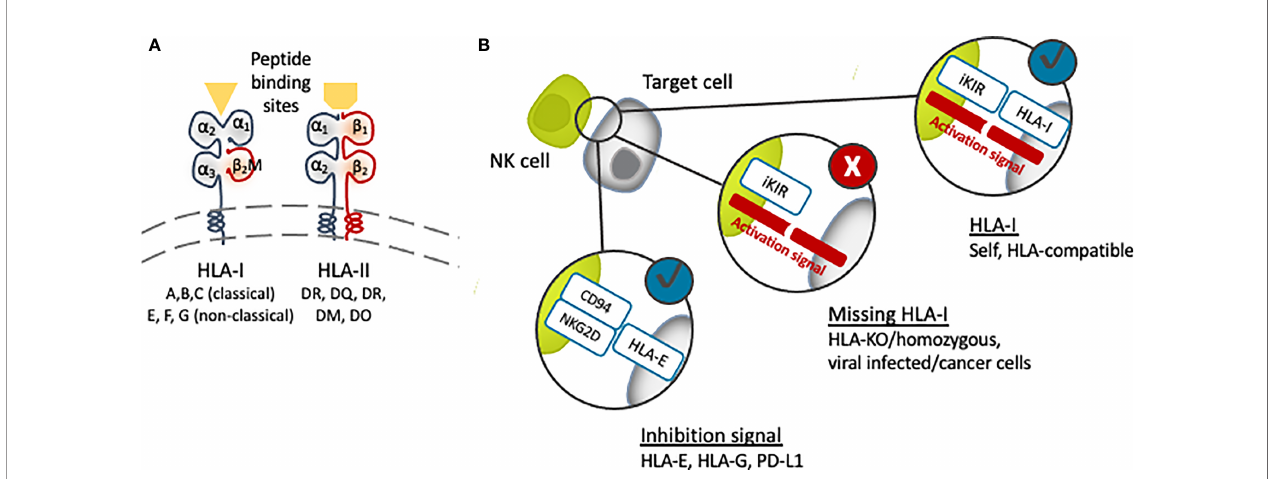
FIGURE 1 | (A) Schematic structure of human leukocyte antigen (HLA). Targeting the b 2M subunit of HLA-I will cause disruption of all HLA-I expression [major (A – C) and minor (E – G)]. (B) The presence of HLA-I matching with the recipient NK cells ’ inhibitory KIR receptor (iKIR) will induce tolerance, while the lack or downregulation of HLA-I will trigger NK cell immunity.